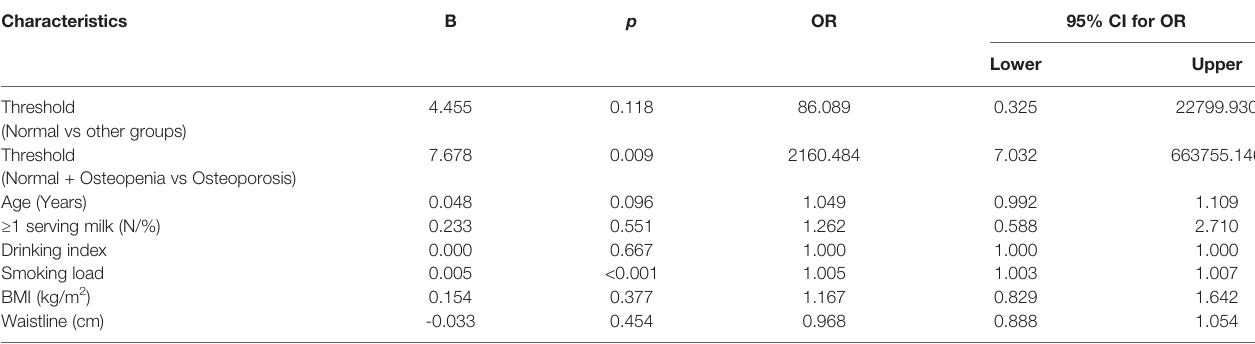
TABLE 2 | Analysis of risk factors for osteoporosis.